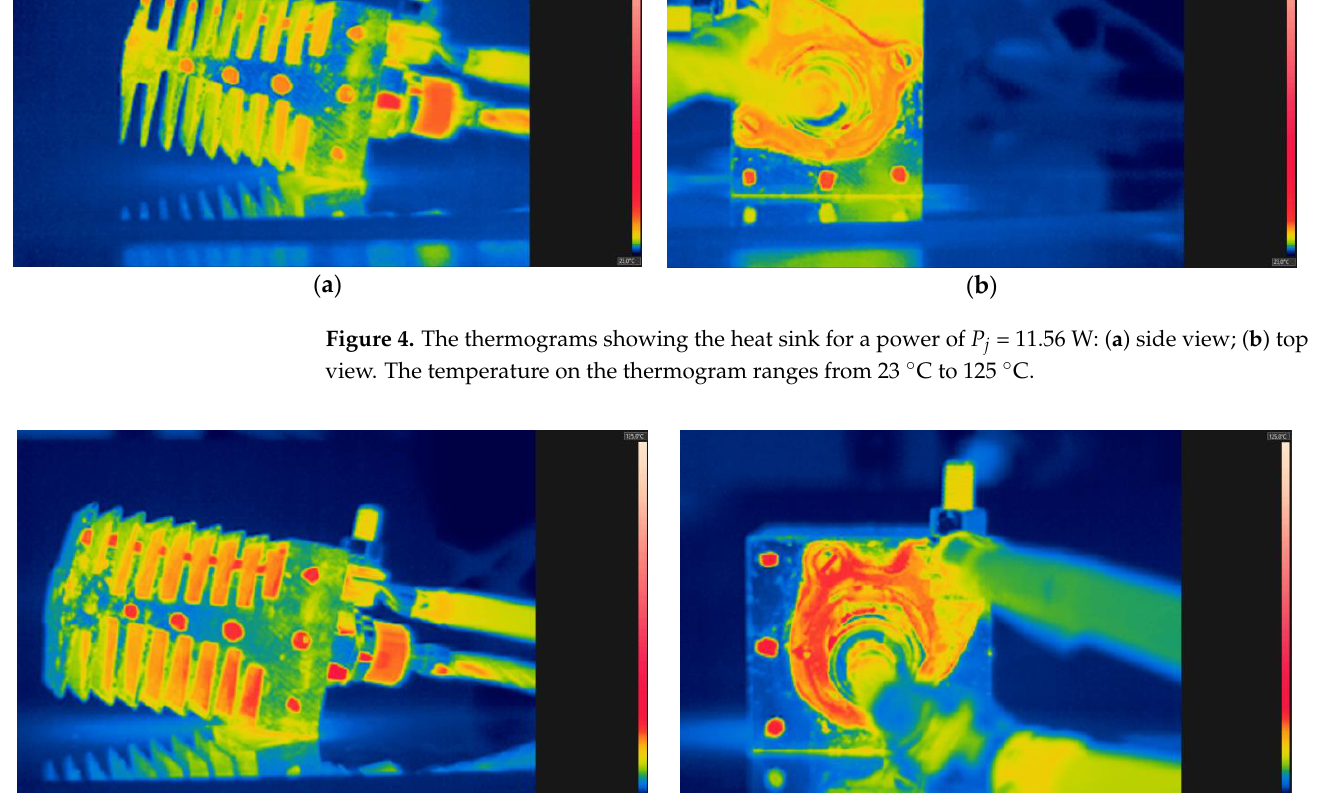
Figure 6. The thermograms showing a heat sink for a power of P j = 49.61 W: ( a ) side view; ( b ) top view. The temperature on the thermogram ranges from 23 °C to 125 °C.